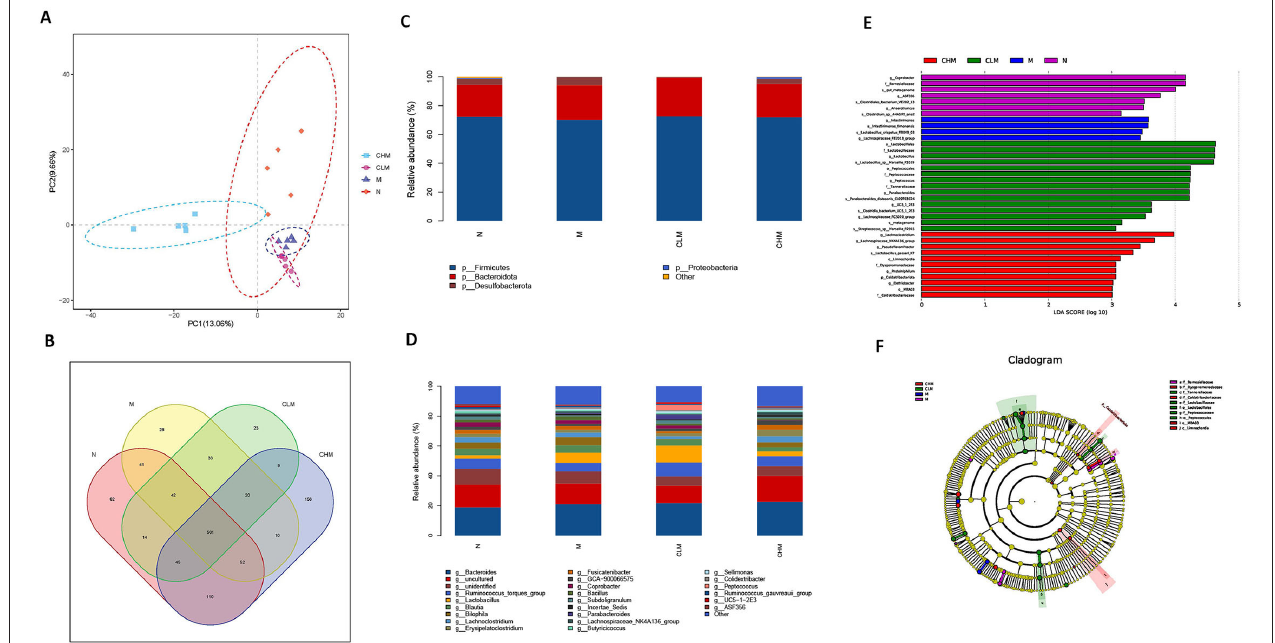
FIGURE 10 | Effects of CSP on intestinal microflora of immunosuppressed chickens. (A) Partial least squares discriminant analysis (PLS-DA). (B) Venn diagram. (C,D) The abscissa is the sample name, and the ordinate is the relative abundance of species in the sample. The graph shows information about species with relative abundance of more than 1%. (C) Microbe distribution at phylum level in different groups. (D) The distribution of microorganisms at the generic level in different groups. (E) Histogram of LDA ditribution based on LEfSe analysis of classification information. (F) Evolutionary branching diagram of LEfSe analysis based on classification